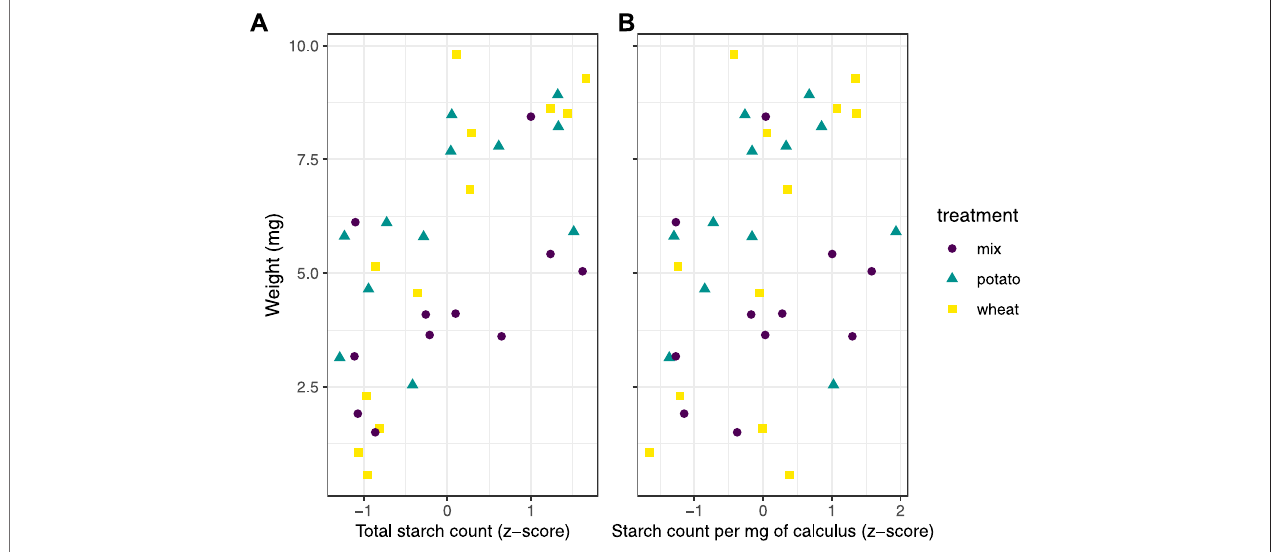
FIGURE 4 | Scatter plots of (A) sample weight in mg and standardised starch count by z-score for separated treatments, and (B) sample weight in mg and standardised count of starch grains per mg calculus.